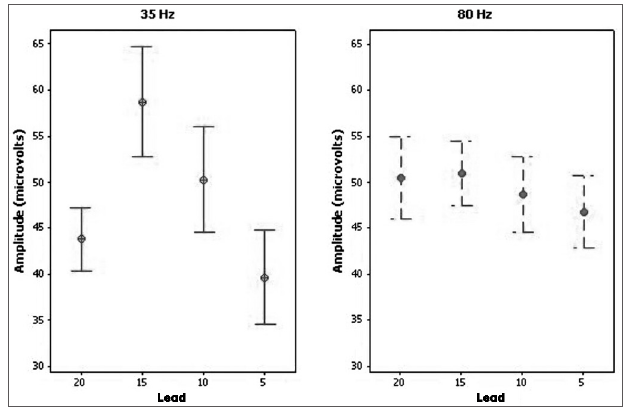
Figure 3. Neural Response Amplitude - Results of means ± standard errors of the neural response amplitude in electrodes 20, 15, 10, and 5, at 35 and 80 Hz stimulation